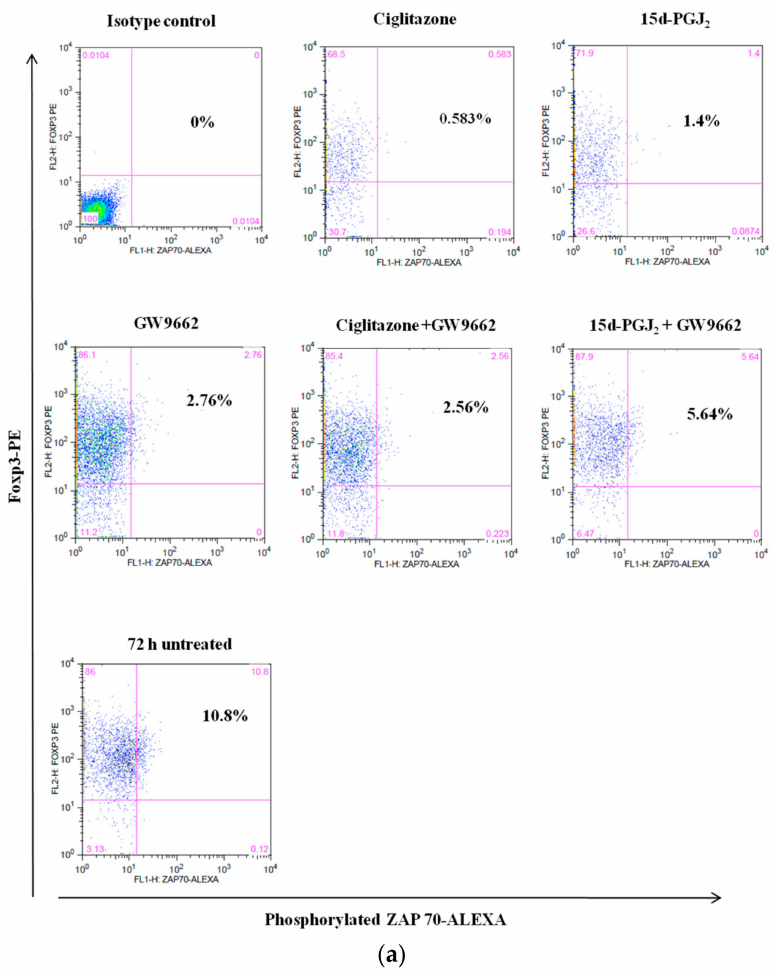
Figure 3. The binding activity between PPAR γ and PPRE in nTreg cells nuclear protein lysates from NOD and NOR mice. The bar graphs show mean absorbance for each indicated treatment performed in duplicate. PPAR γ double-stranded DNA (dsDNA) competitors were added onto dsDNA competitor wells while non-specific binding (NSB) wells were added with buffer without positive control or samples. Blank wells contained only buffer. This experiment was repeated twice and error bars represent mean ± SEM ( n = 3